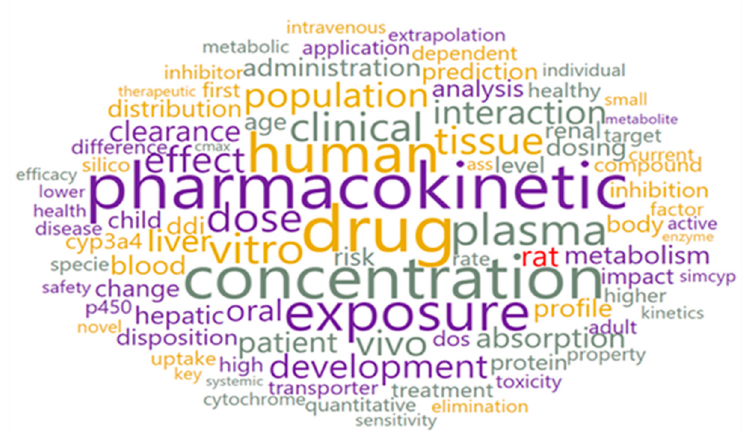
Figure 4. Word cloud for the whole corpus.